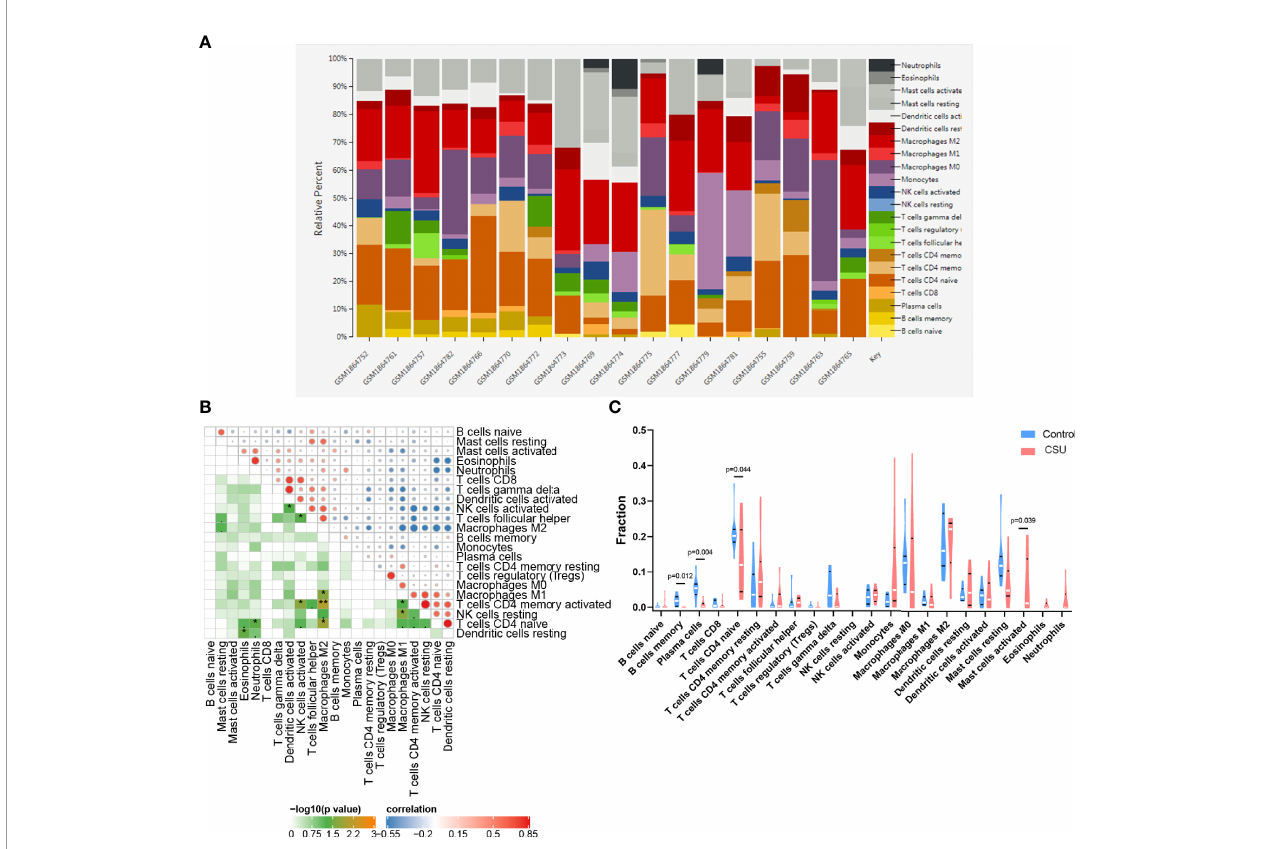
FIGURE 5 | Immune in fi ltration analysis of CSU. (A) The ratio of 22 immune cells of each sample of CSU. (B) The correlation between each of immune cells. (C) The proportion of immune cells in CSU and